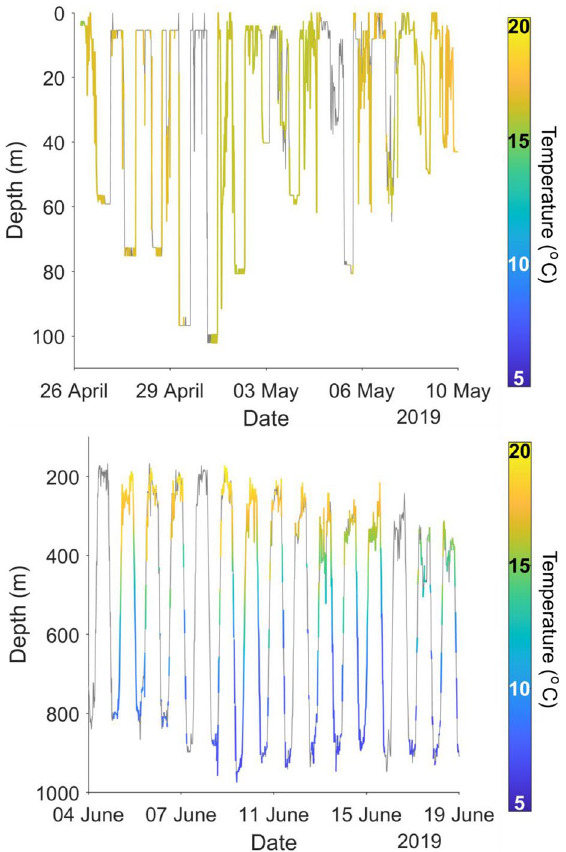
Figure 2. Example of a short-finned eel (179358) remaining in shallow water on the Australian continental shelf during the first days following tagging (top panel), followed by regular diel vertical migration, moving from shallower to deeper water between night and day once in deep water (bottom panel), showing depth coloured by temperature (°C). Note: grey denotes where a corresponding temperature was not available for a depth